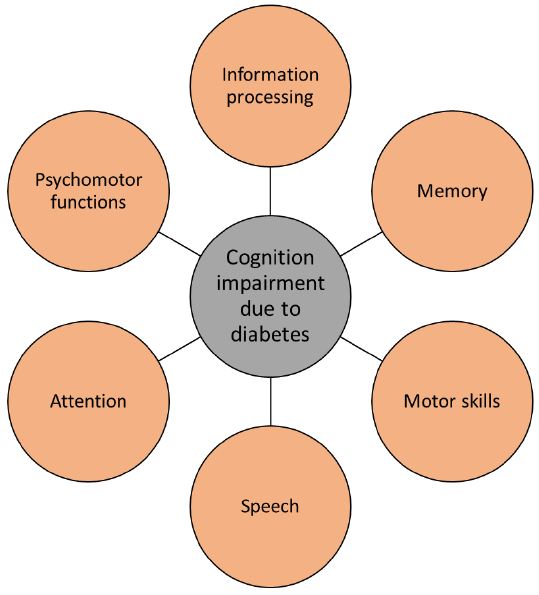
Figure 4. Diabetes causes several cognitive impairments, typical for Alzheimer’s disease.